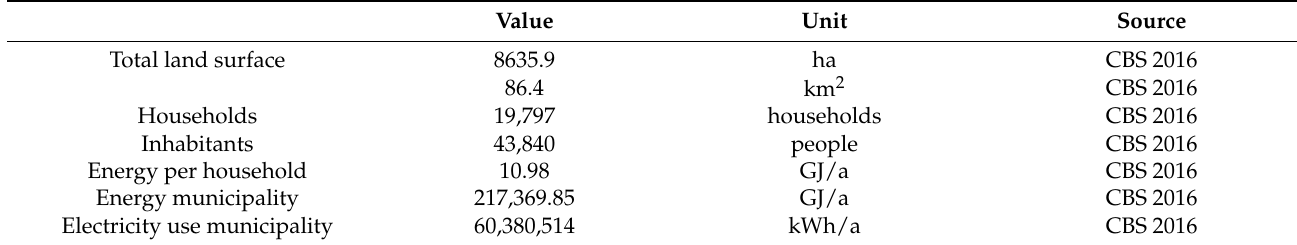
Table A2. Data average municipality.